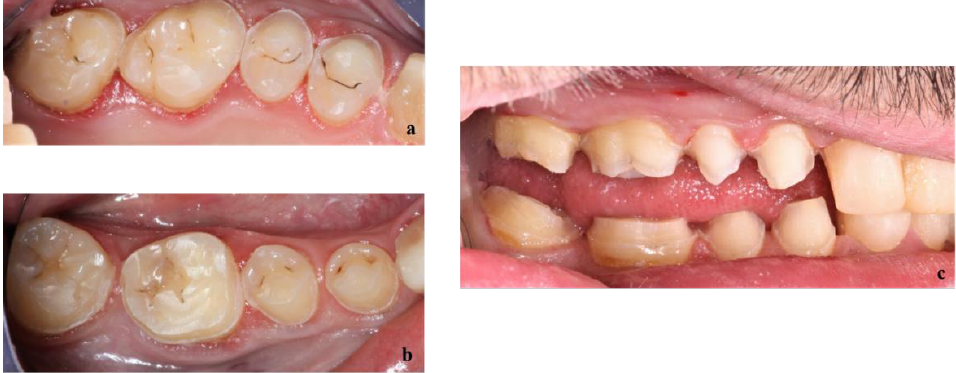
Figure 6. Final teeth preparations on the upper right side ( a ), on the lower right side ( b ), in occlusal view on the right side ( c ).